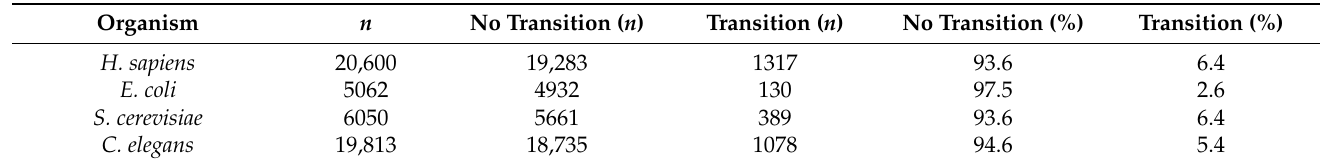
Table 1. Classification of pH-dependent disorder for the proteomes of four different model organisms. Most proteins remain in a defined conformational state (no transition). However, a smaller but significant proportion of the proteins in each proteome exhibits pH-dependent conditional disorder (transition).